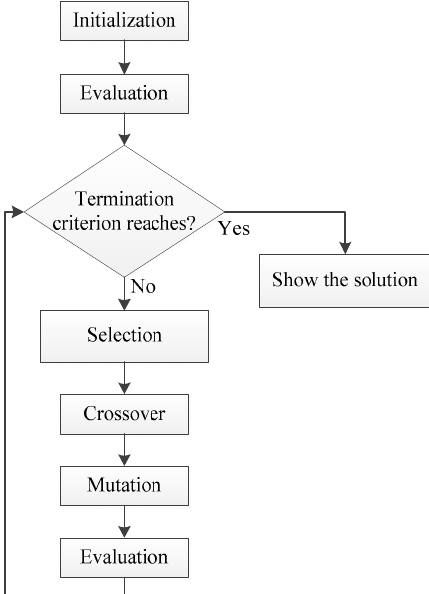
Figure 3. Genetic Algorithm flowchart of the basic steps.